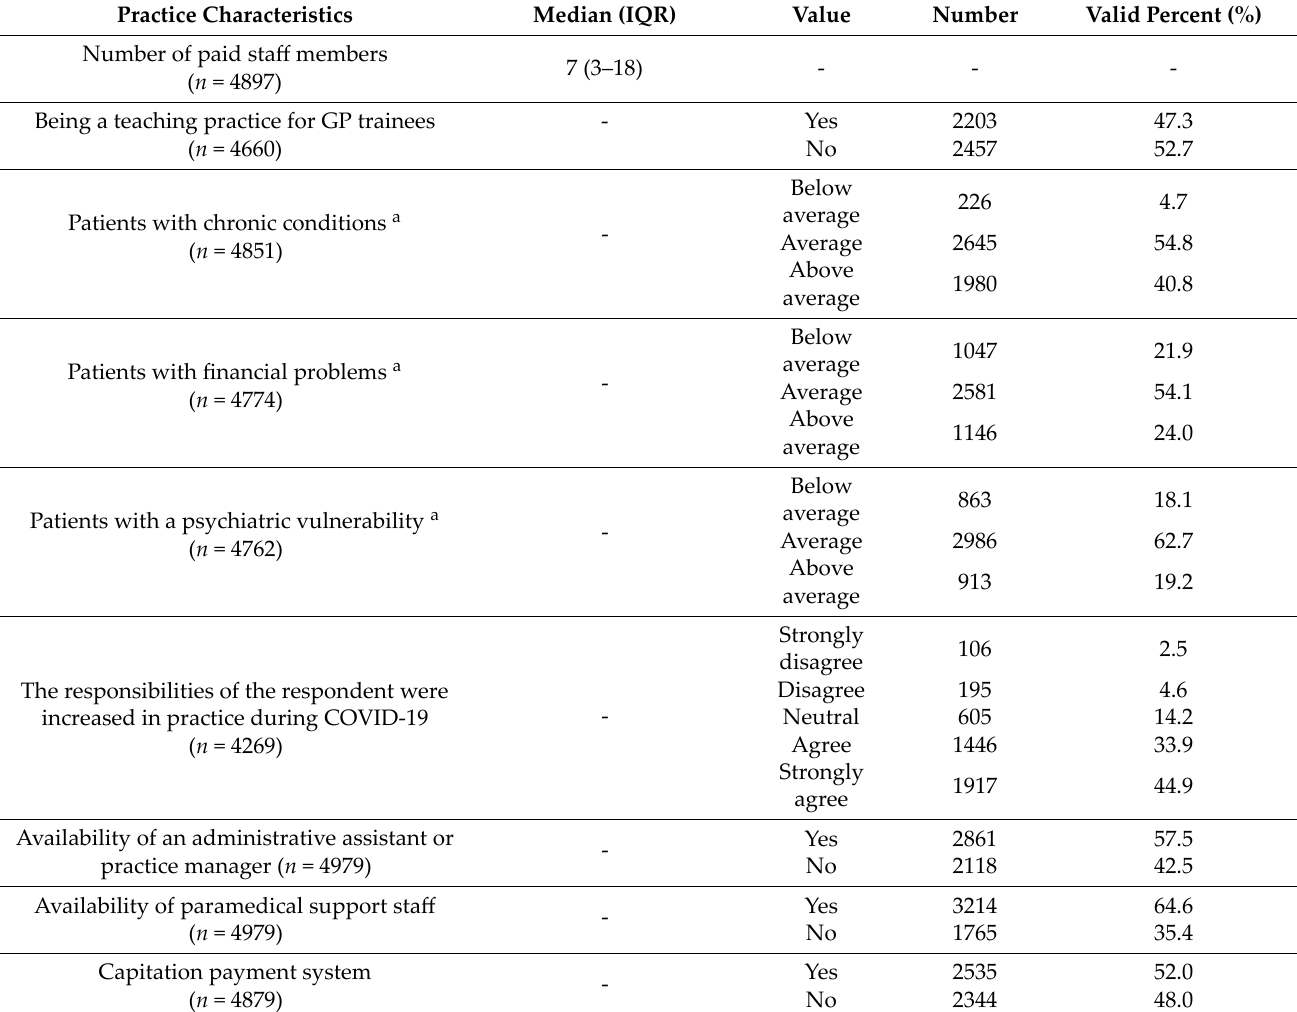
Table 2. A description of the practice characteristics of the participating GP practices ( n =